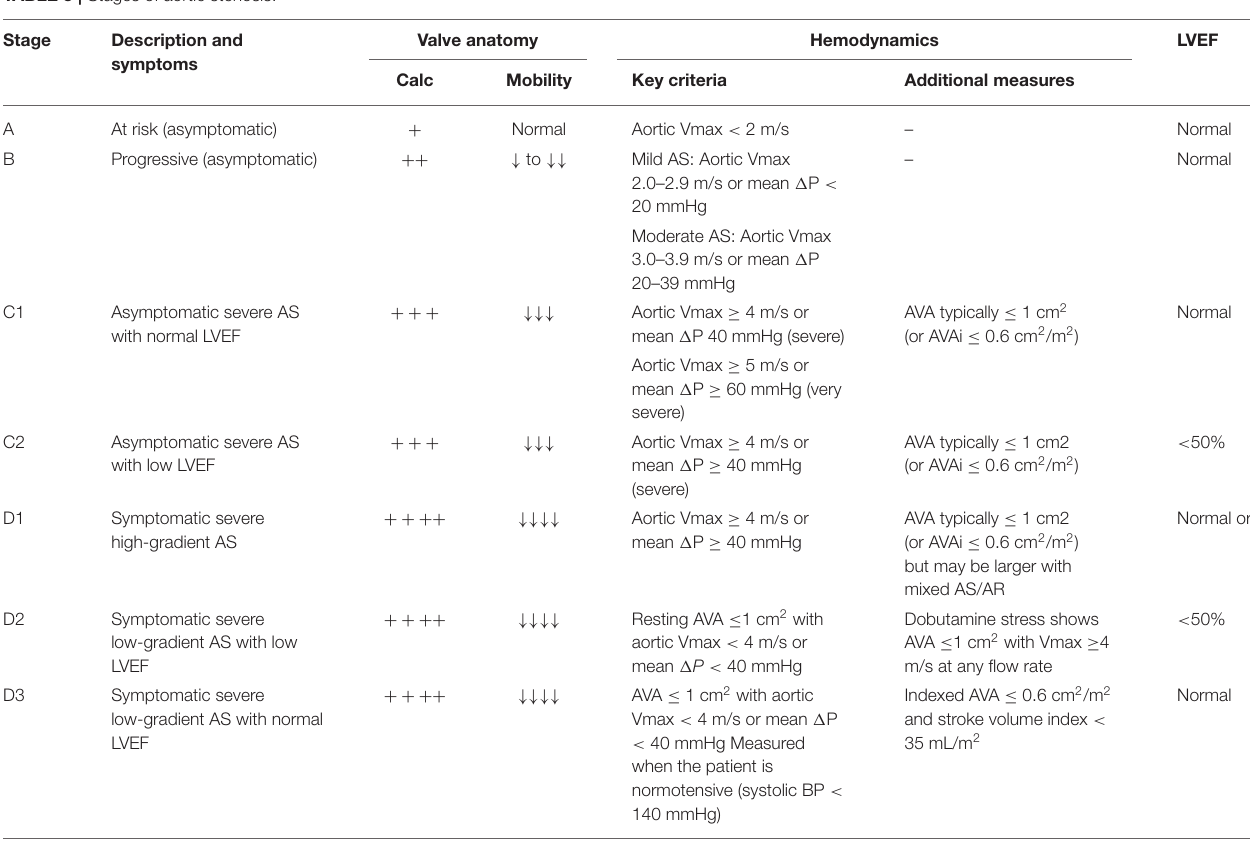
TABLE 3 | Stages of aortic